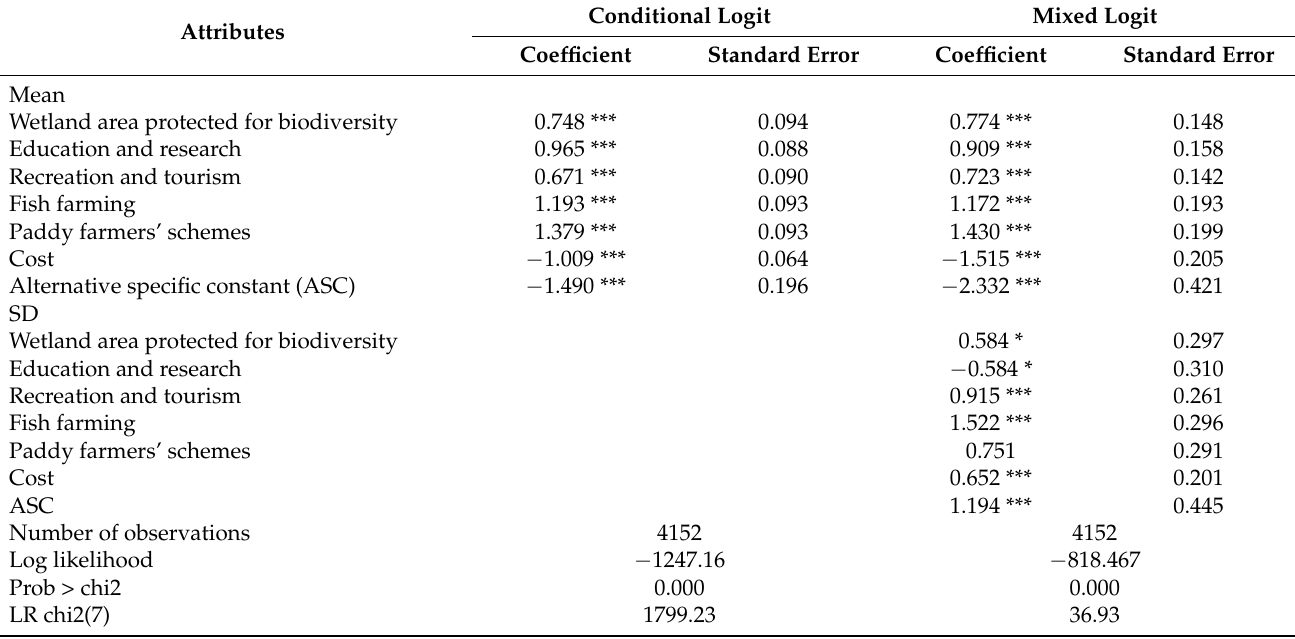
Table 4. Marginal coefficient estimates for sustainable wetland management attributes.